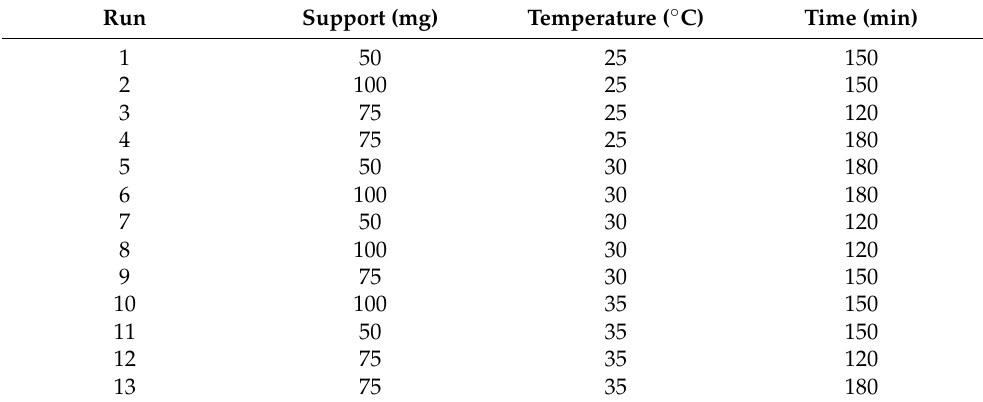
Table 1. Experimental design of the Box–Behnken response surface (amount of support, temperature, and